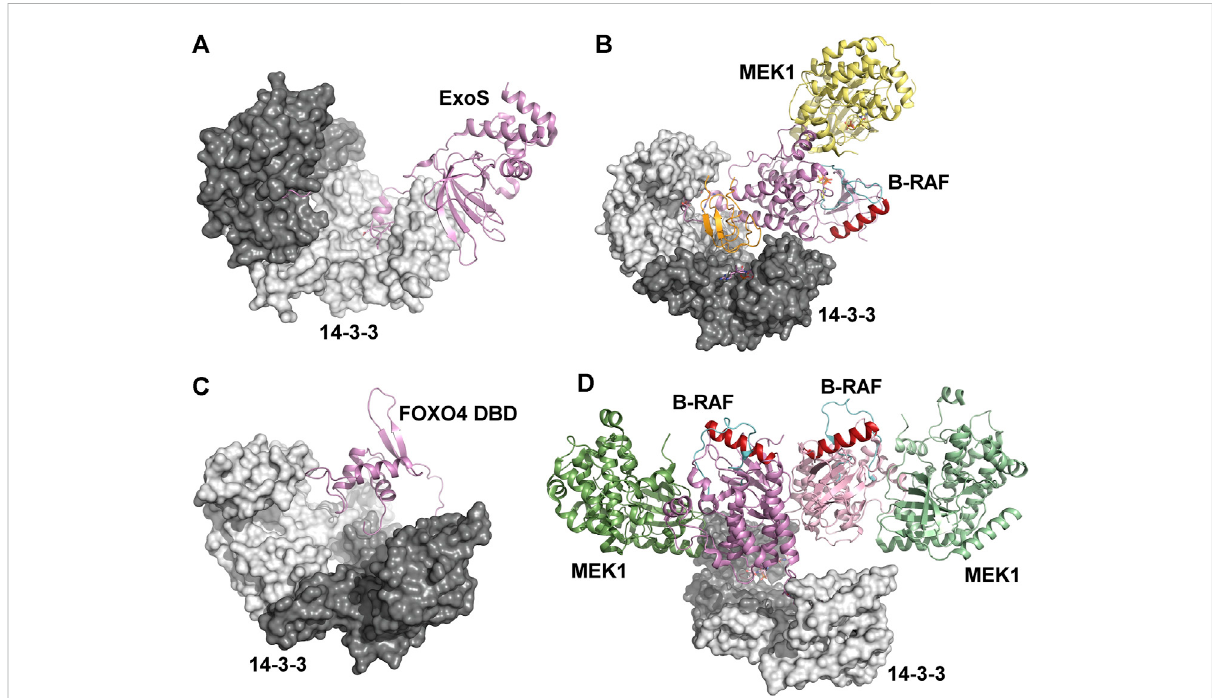
FIGURE 4 Mechanisms based on physical occlusion and facilitation of protein-protein interactions. (A) Crystal structures of the ExoS:14-3-3 β complex showing an extensive hydrophobic binding interface. The amphipathic 14-3-3 binding LDLA-motif is shown as sticks (Karlberg et al., 2018). (B) AutoinhibitedB-RAF:MEK1:14-3-3complex(PDB ID:6NYB (Parketal., 2019)).The CRD andthecatalyticdomains ofB-RAF areshown inorange and violet, respectively. The position of the C-helix (shown in dark red) and the activation segment (shown in cyan) correspond to the autoinhibited state. (C) The Förster resonance energy transfer-based model of the complex between the FOXO4 Forkhead domain (FOXO4 DBD) and 14-3-3 ζ (Silhan et al., 2009). The 14-3-3 binding motifs is located at the C-terminus of FOXO4-DBD. (D) The active B-RAF:MEK1:14-3-3 complex (PDB ID: 6Q0J (Park et al., 2019)). The 14-3-3 dimer anchors C-terminal 14-3-3 binding motifs of two B-RAF molecules, and the B-RAF kinase domains are oriented in the back-to-back fashion with the C-helix (shown in dark red) in a position consistent with the active conformation. The fi gure